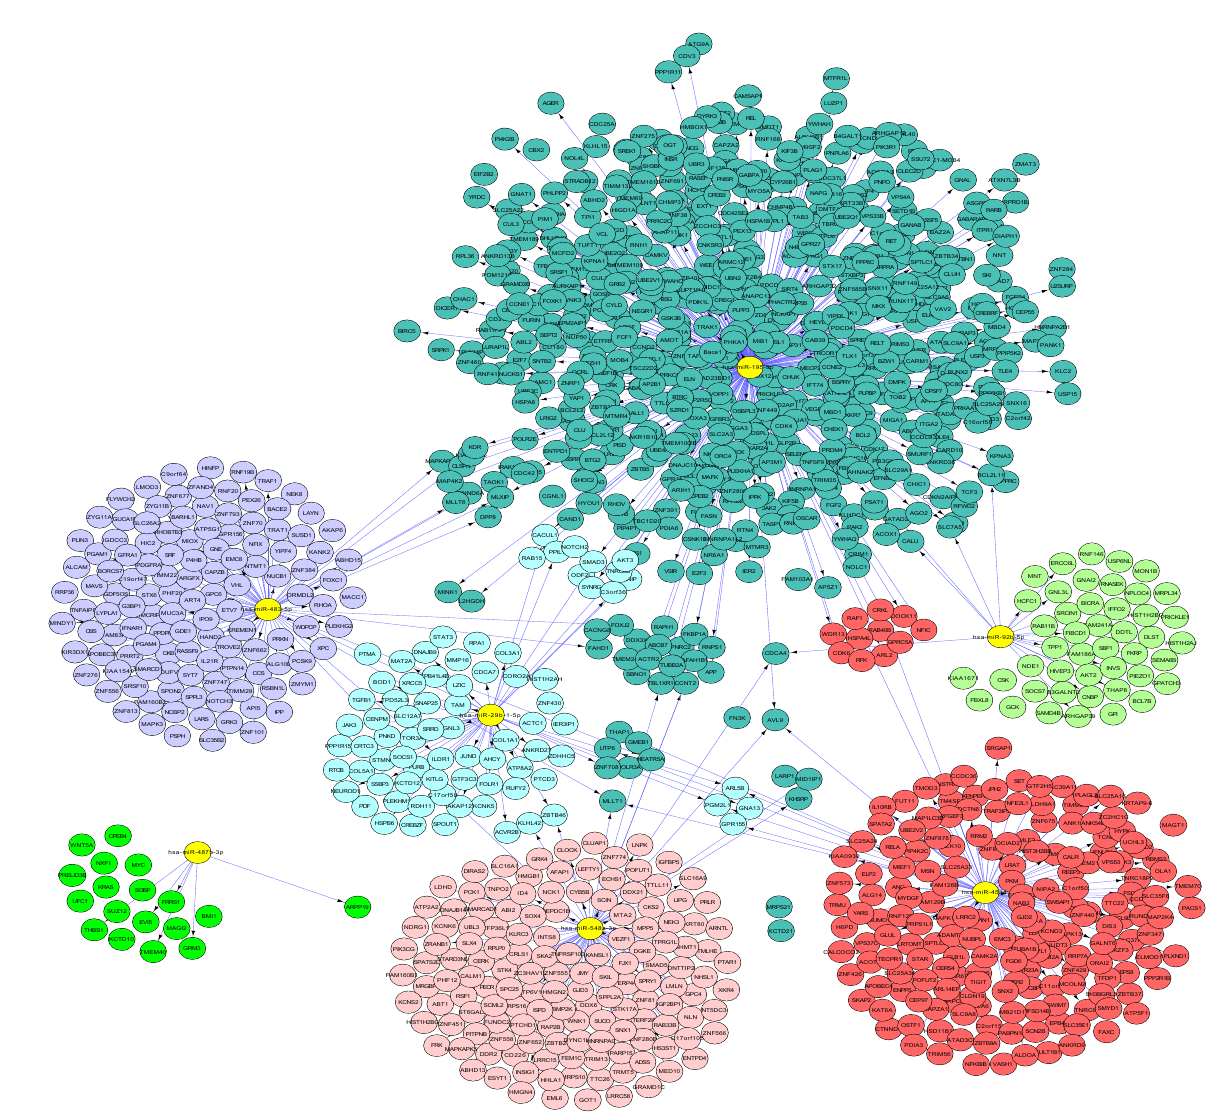
Figure 3. Interaction networks between target genes and the seven-miRNA signature. Target genes and the seven-miRNA signature were visualized with Cytoscape and CyTargetLinker. miRNAs are marked in yellow, while target genes are color-coded according to their regulatory miRNAs.